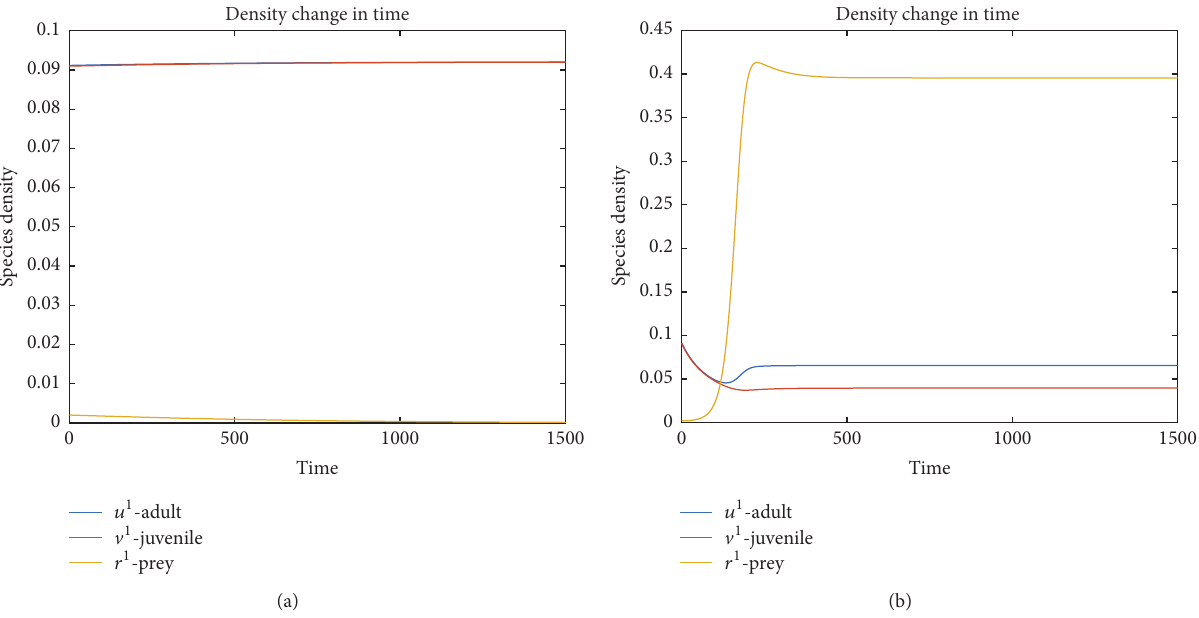
Figure 8: Here we demonstrate that cannibalism can act as a lifeboat for the prey species also. The values of the parameters here are 𝑟 = 0.01 , = 0.09. We see in (a) that, with 𝑠 = 0 , or no cannibalism, the prey is driven to extinction. However, in (b), 𝑚 = 0.01 . 𝛾 = 0.01 , 𝑢 = 0.062 , 𝑡 1 we see that introducing a little bit of cannibalism, that is, by choosing 𝑠 = 0.1 , the prey population immediately rebounds to a high